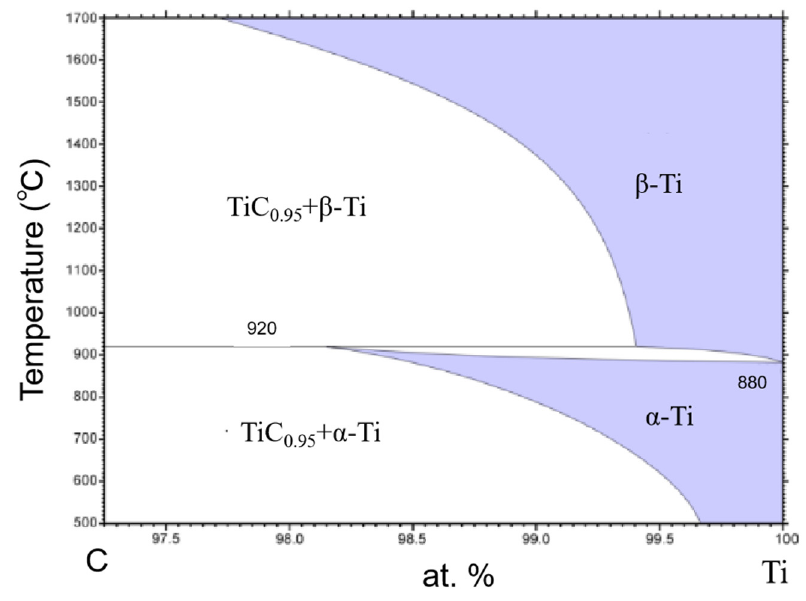
Figure 5. Binary phase diagram of Ti-C low carbon region [23].